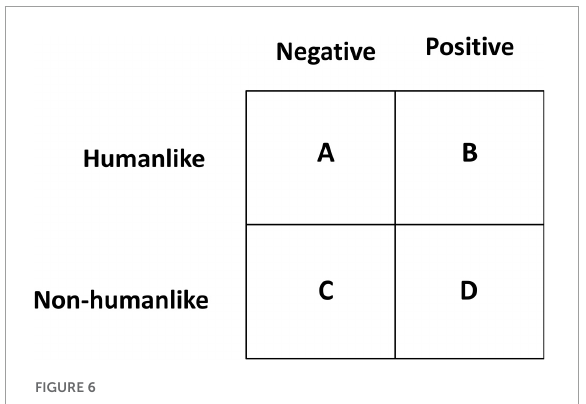
FIGURE6 Characteristics of VAs compared with human